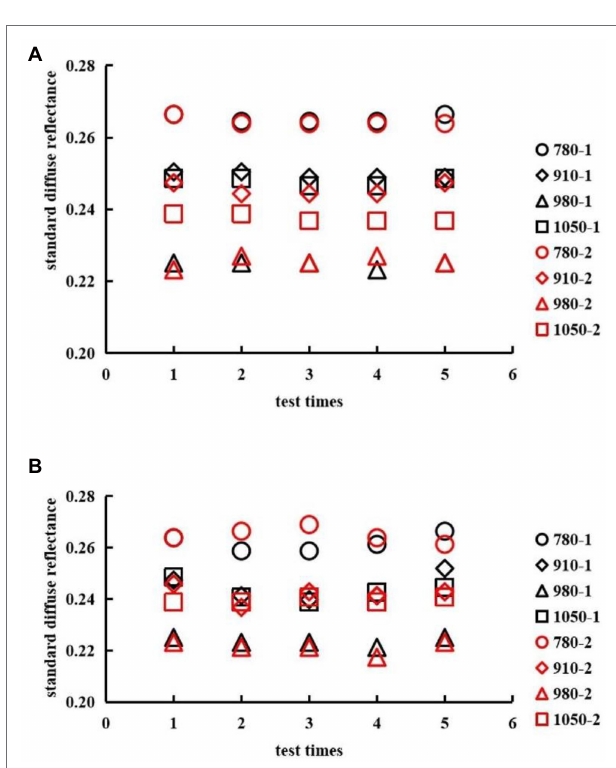
FIGURE 17 | Performance test of the PSPMWG. (A) Noise level, (B)